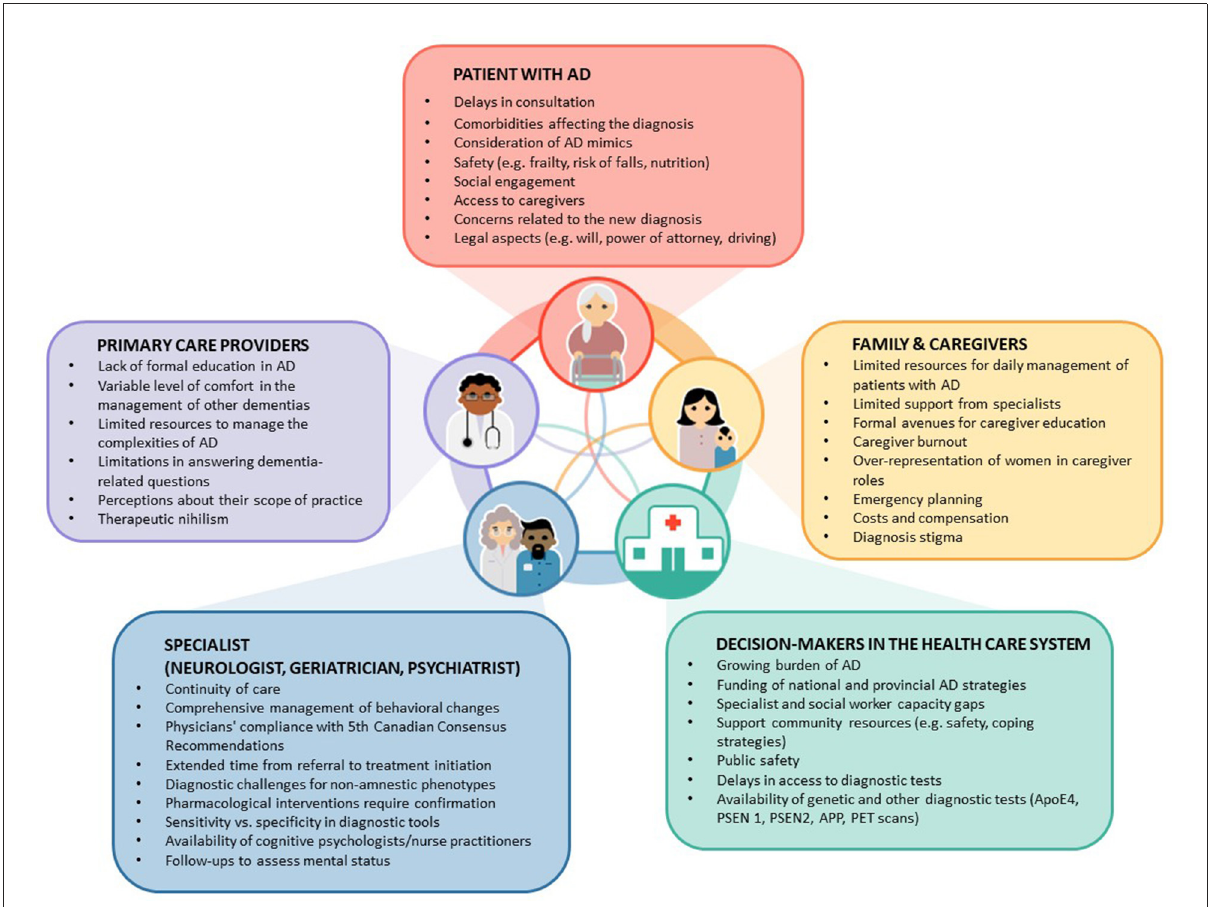
FIGURE1 Gaps and barriers in the diagnosis and management of patients with Alzheimer’s Disease (AD) in primary care. This figure illustrates factors and existing gaps in the management of patients with AD. It shows the complex interactions among key players: Patients, family members and caregivers, and decision-makers. Text in the boxes identify specific gaps or issues. Note that the most common point to initiate investigations starts by symptoms disclosed by patients or their family members and